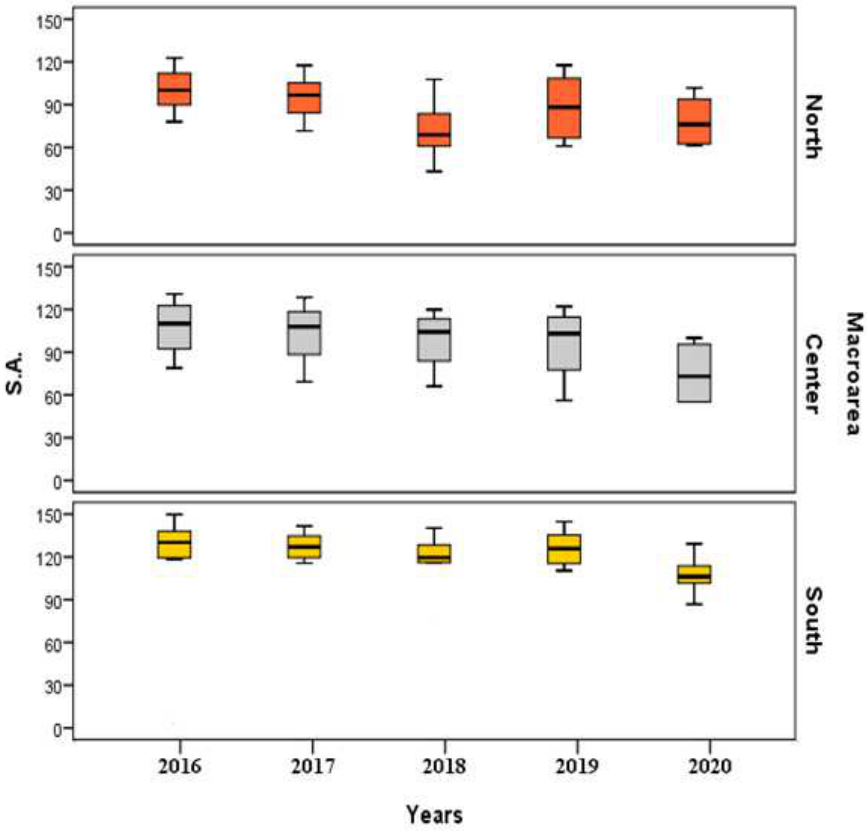
Figure 3. Boxplots of standardized rates of SA (2016–2020).